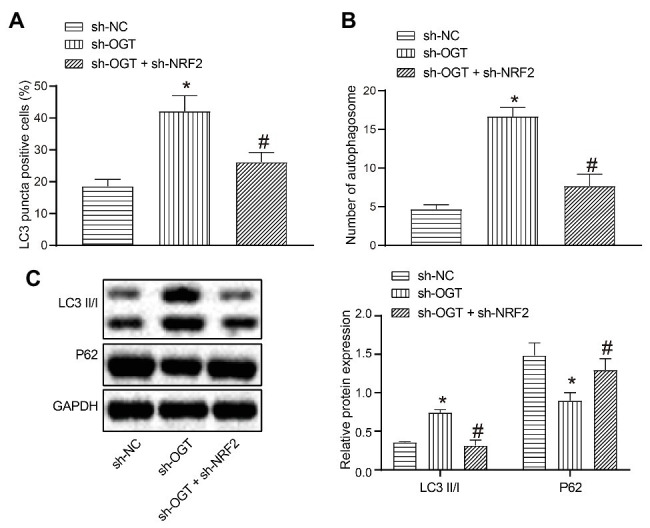
OGT inhibits cell autophagy through the KEAP1/NRF2 axis. (A) Quantitative analysis of immunofluorescence assay for proportion of LC3-positive cells in response to OGT knockdown and NRF2 knockdown. (B) Quantitative analysis of autophagosomes formation in response to OGT knockdown and NRF2 knockdown. (C) Western blot analysis of autophagy-related proteins light chain 3II (LC3II)/I and P62 normalized to GAPDH in response to OGT knockdown and NRF2 knockdown. *p < 0.05 vs. cells transduced with sh-NC; #p < 0.05 vs. cells transduced with sh-OGT (in vitro experiments were repeated three times independently).